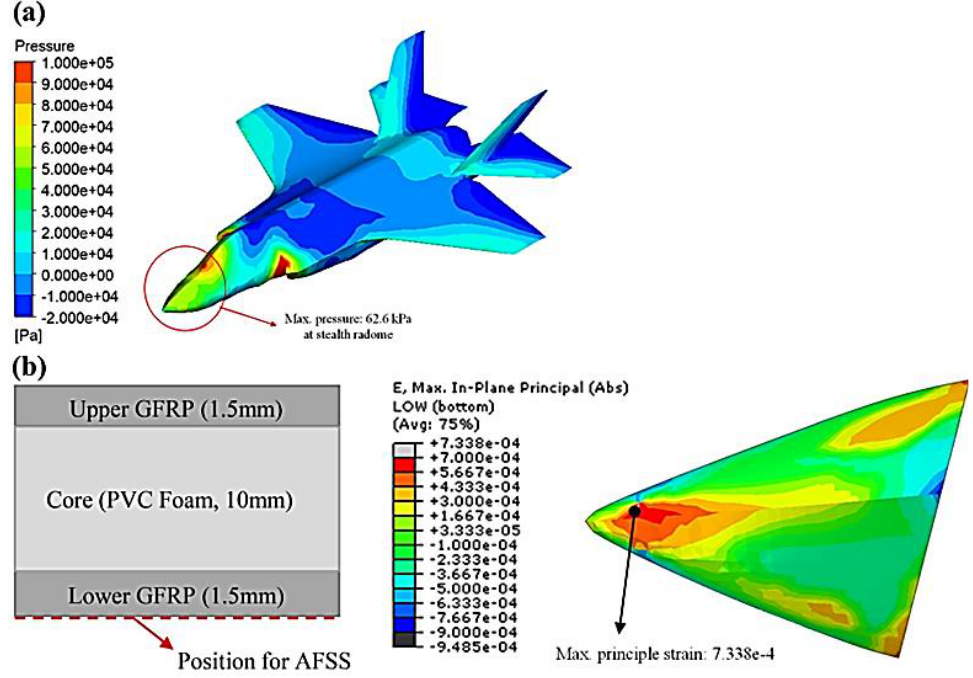
Figure 18. F-35 aircraft ( a ) flow analysis and ( b ) cross section of sandwich composite and principal strain on sandwich composite of glass fiber reinforced plastics (GFRP) with a poly(vinyl chloride) core [152]. Reproduced with permission from